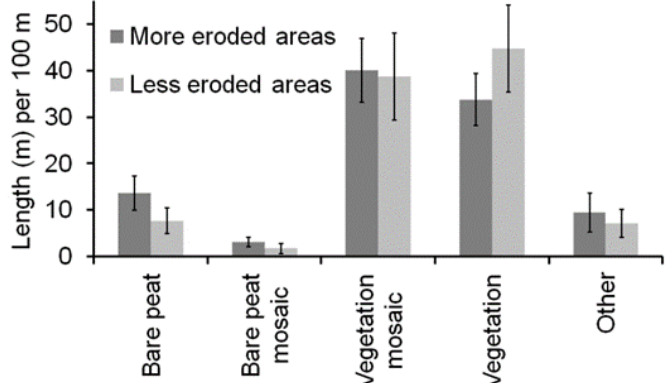
Figure 3. Large-scale ground cover in the study area: lengths of bare peat, vegetation and mosaics along 100 m transect surveys, by survey stratum (mean and s.e.). Mosaics are labelled according to whether bare peat, or vegetation, was the more common component of ground cover. 'Other' comprised open water, mosaics including open water, or more complex mosaics of three of more features.